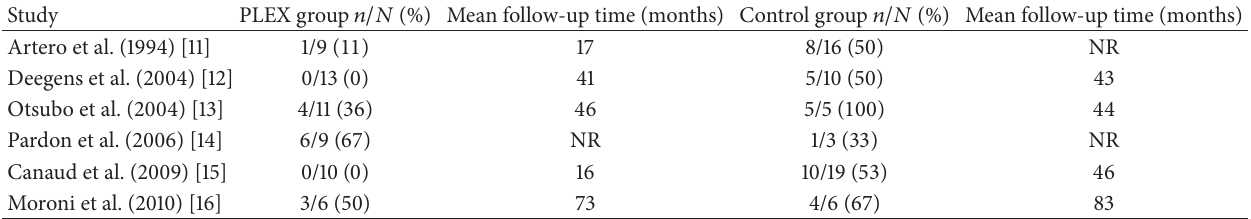
Table 3: Renal allograft loss due to recurrence and mean follow-up time. NR: not reported; PLEX: plasma exchange.